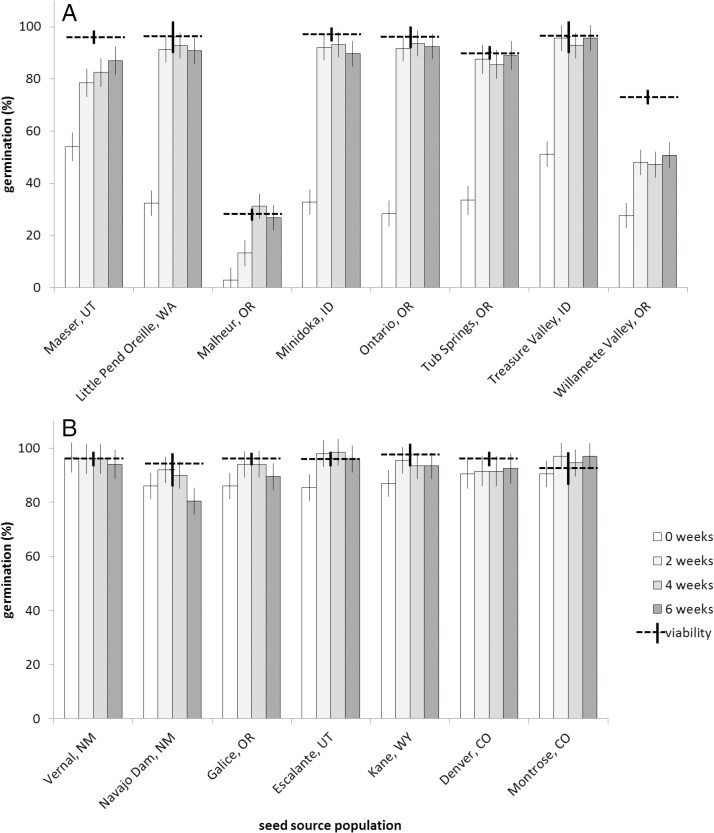
Seed germination in response to different periods of cold stratification for 15 populations of Asclepias speciosa (A) dormant seeds and (B) non-dormant seeds. Seed viability as estimated with TZ is shown with horizontal hatched lines. Error bars represent 95 % confidence intervals.